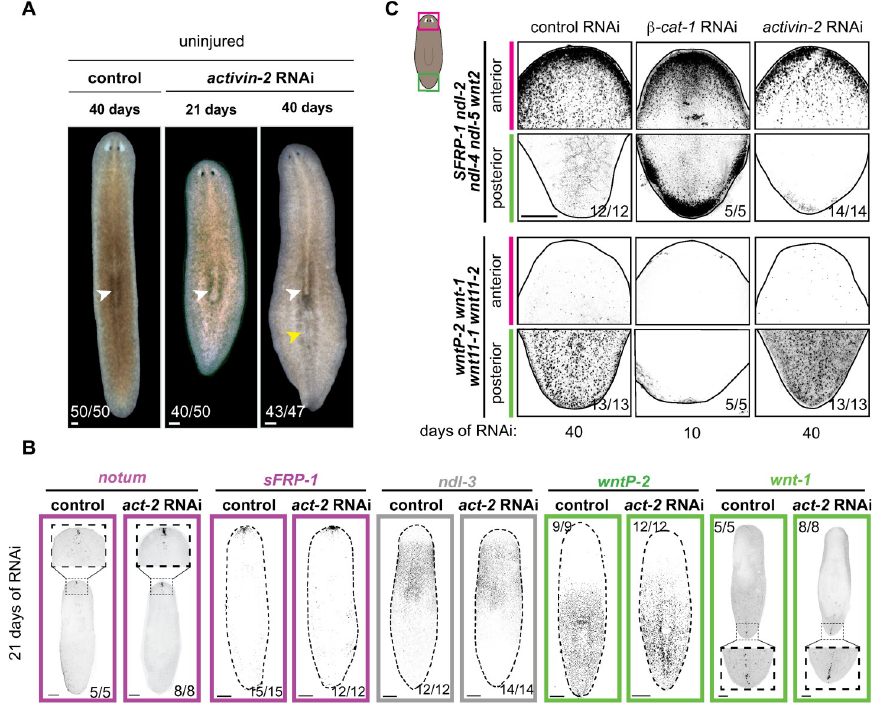
Fig 2. Intact activin-2 RNAi animals do not show polarity defects in patterning gene expression. (A) Uninjured activin-2 RNAi animals at 21 and 40 days after first RNAi feeding. Original pharynges (white arrows) and ectopic pharynx (yellow arrow) are shown. (B) FISH shows normal PCG expression and pole presence in uninjured activin-2 ( act-2 ) RNAi animals at 21 days after first RNAi feeding. (C) Intact activin-2 RNAi animals display maintenance of anterior and posterior identity at 40 days RNAi by FISH. Bn contrast, β -catenin-1 RNAi promotes a loss of posterior identity, and ectopic anterior identity in intact animals by 10 days of RNAi. (Top) A pool of anterior restricted genes ( sFRP-1 , ndl-2 , ndl-4 , ndl-5 , and wnt2 ), (Bottom) A pool of posteriorly expressed genes ( wntP-2 , wnt1 , wnt11-1 , and wnt11-2 ). All images are anterior up. Scale bars, 200 μ